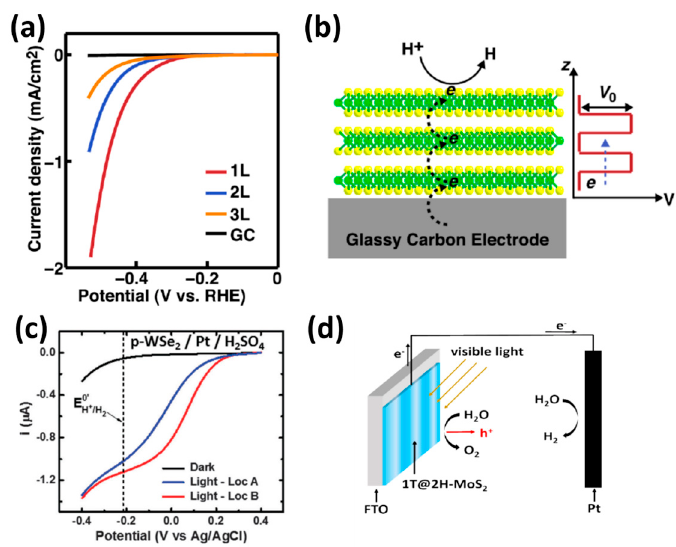
Figure 9. ( a ) Polarization curves of the monolayer (red, 1 L), bilayer (blue, 2 L), and trilayer (orange, 3 L) MoS 2 films [76]; ( b ) Hopping of electrons in the vertical direction of MoS 2 layers [76]; ( c ) Linear sweep voltammograms of p-MoS 2 /Pt obtained with and without laser beam irradiation, respectively [78]; ( d ) Schematic representation of photoelectrochemical cells with 1T-2H-MoS 2 on FTO as photoanode